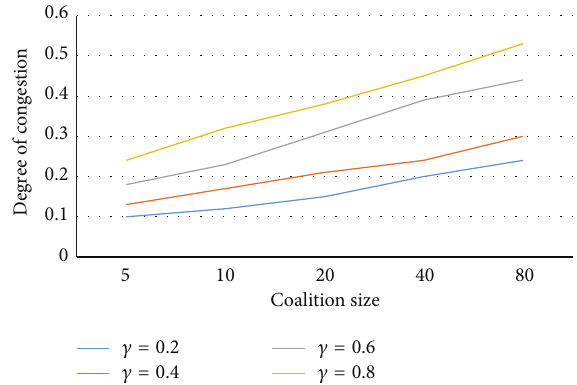
Figure 12: System overhead percentage with different numbers of neighboring nodes.